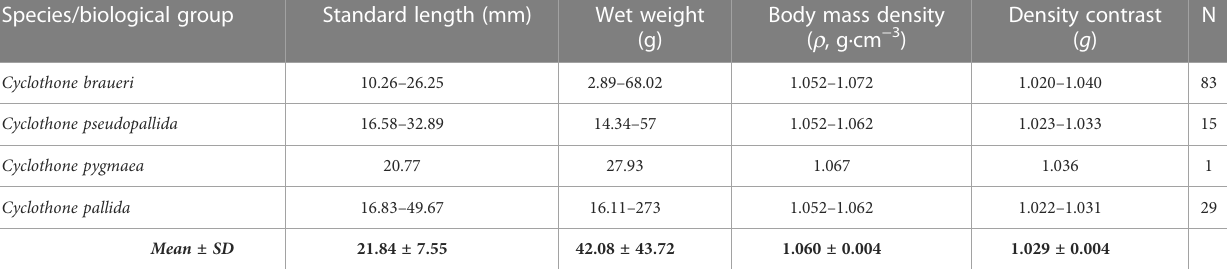
TABLE 7 Summary of the body-mass density experiment results obtained for species sampled in Mediterranean waters down to 700 m depth. Species/biological